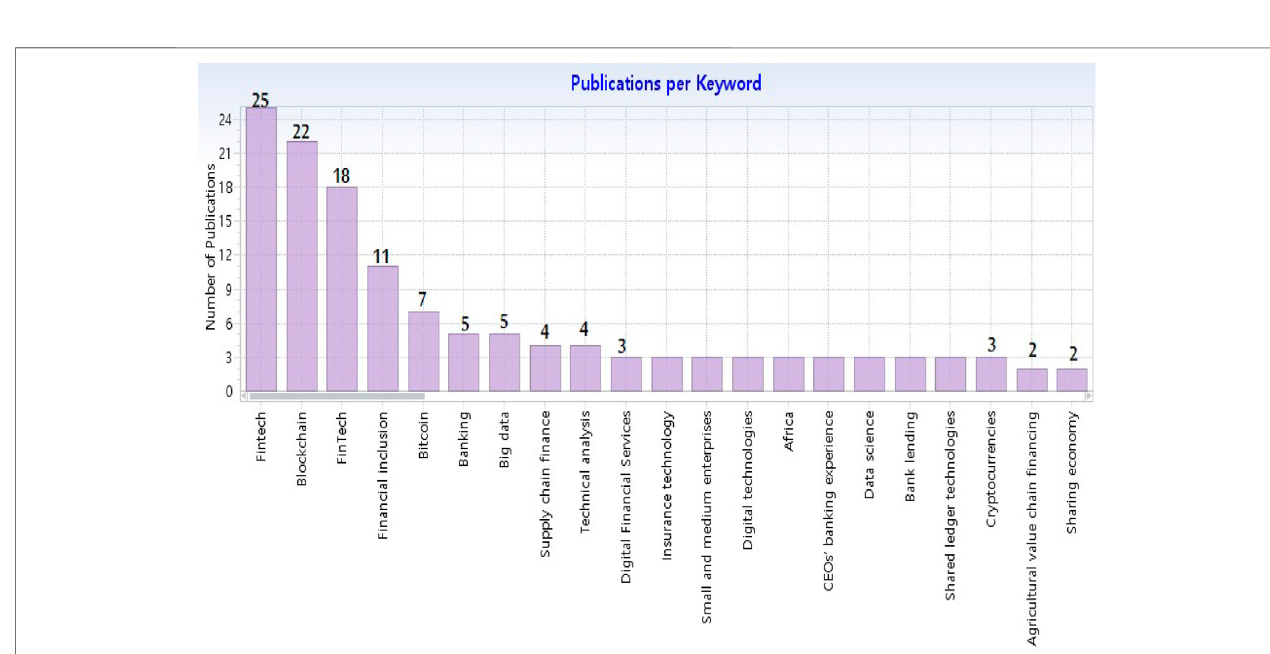
FIGURE 2 | Publications per